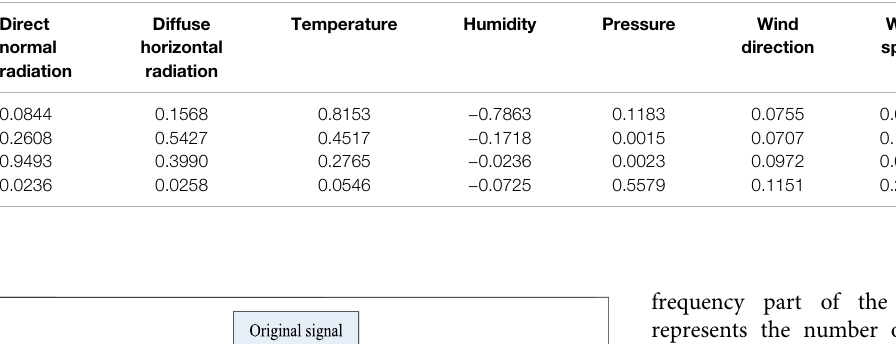
TABLE 1 | Correlation coef fi cients of factor analysis.